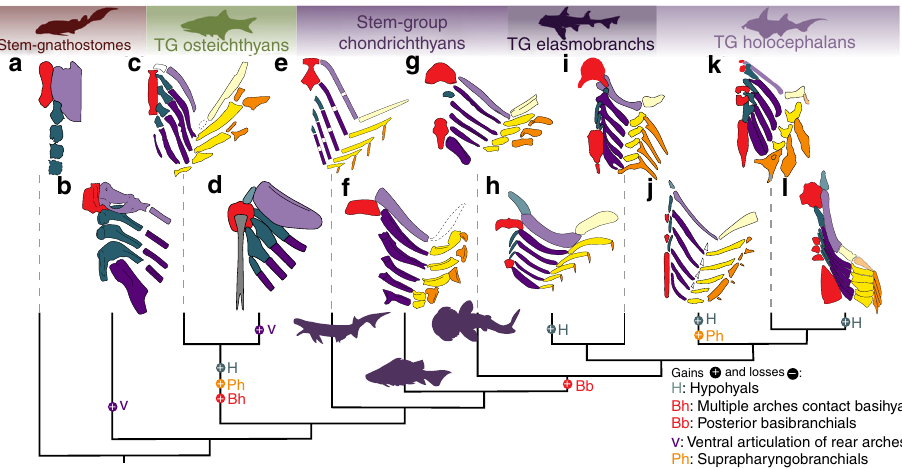
Fig. 4 The phylogenetic distribution of branchial arch morphologies in gnathostomes. The scheme of relationships is based on the strict consensus tree derived from the parsimony analysis described in the methods. Character changes of selected pharyngeal arch characters from our analysis are plotted using an ACCTRAN optimisation. Taxa shown are a Cowralepis 47 , b Paraplesiobatis 21 , c Raynerius 16 , d Glyptolepis 48 , e Acanthodes (data from refs. 17,30 ), f Ptomacanthus , g Gladbachus 6 , h Triodus 49 , i Scyliorhinus 5 , j Ozarcus 5 , k Callorhinchus 5 , l Debeerius 14 . Colour scheme: as in Fig. 2, with addition of: light turquoise, hypohyal; dark turquoise, hypobranchial; grey, urohyal; pale orange, pharyngohyal. Silhouettes from refs. 19,30,50 and Phylopic. Phylopic images of Bothriolepis and Callorhinchus milii were submitted by Ghedoghedo and Tony Ayling (vectorised by Milton Tan) respectively. Both were distributed